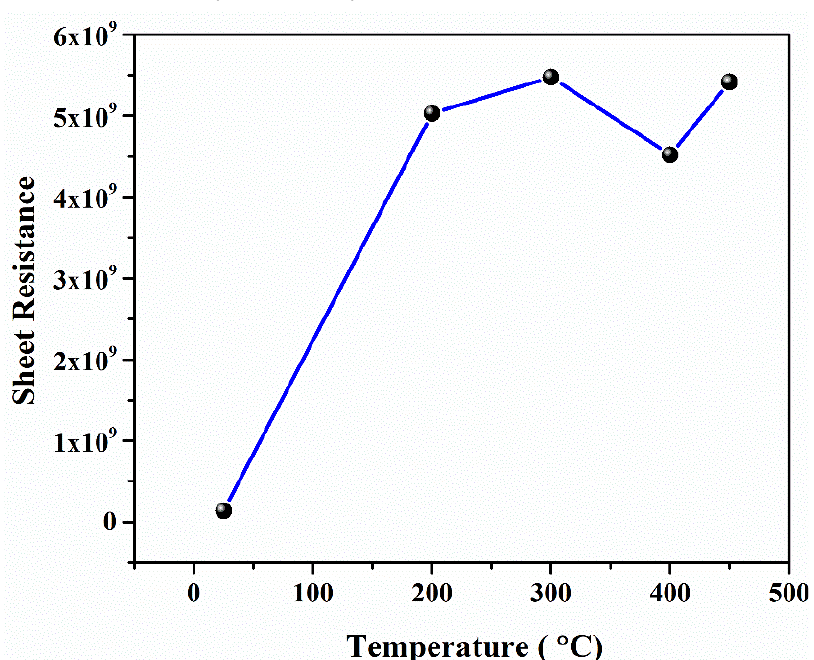
Figure 8. Sheet resistance of PbS thin